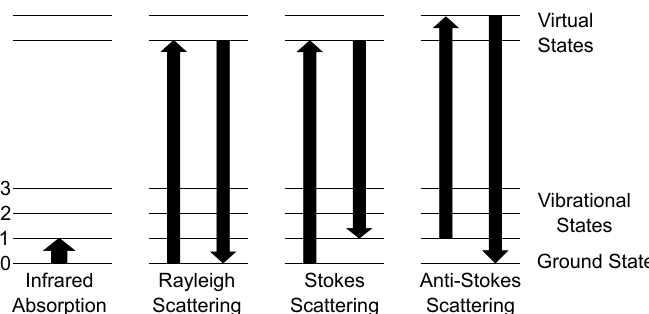
Figure 1. Schematic of the possible scattering processes between a photon and a molecule and ground state 0 and three vibrational states 1–3. Left: Infrared absorption process is governed by absorption of a photon with the energy of equal to the difference between the ground state and a vibrational state. Rayleigh scattering marks the elastic scattering process as energy is neither gained nor lost. The Raman scattering processes are denoted as Stokes and anti-Stokes scattering. Stokes scattering leads to a red-shift of the scattered spectrum with respect to the Rayleigh-line, since the final state is a higher vibrational level than the ground state. Anti-Stokes, on the other hand, starts at a higher state and ends at the ground state, resulting in a blue-shift of the